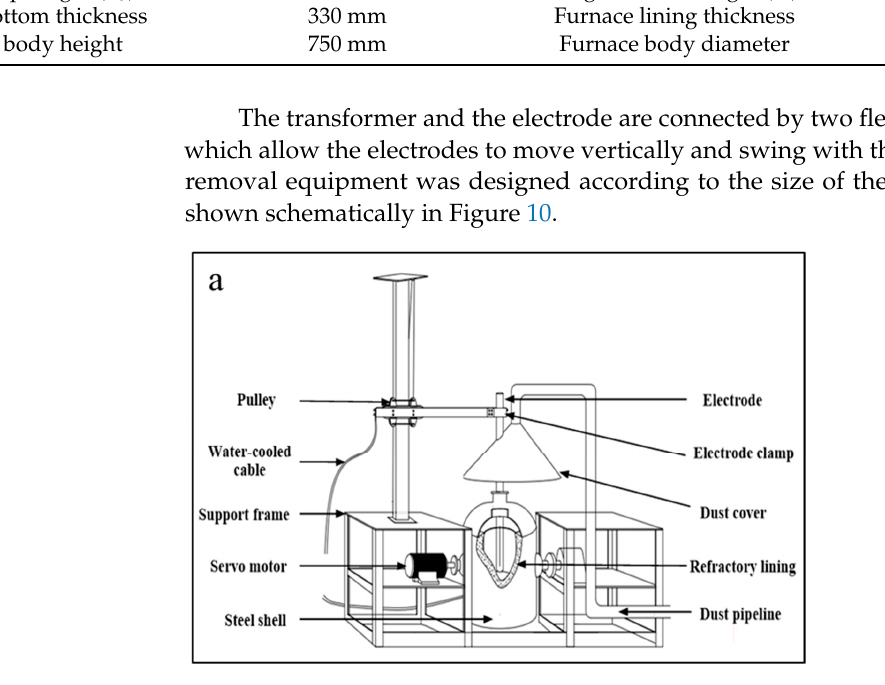
Figure 10. ( a ) Schematic diagram and ( b ) image of the electric arc furnace.